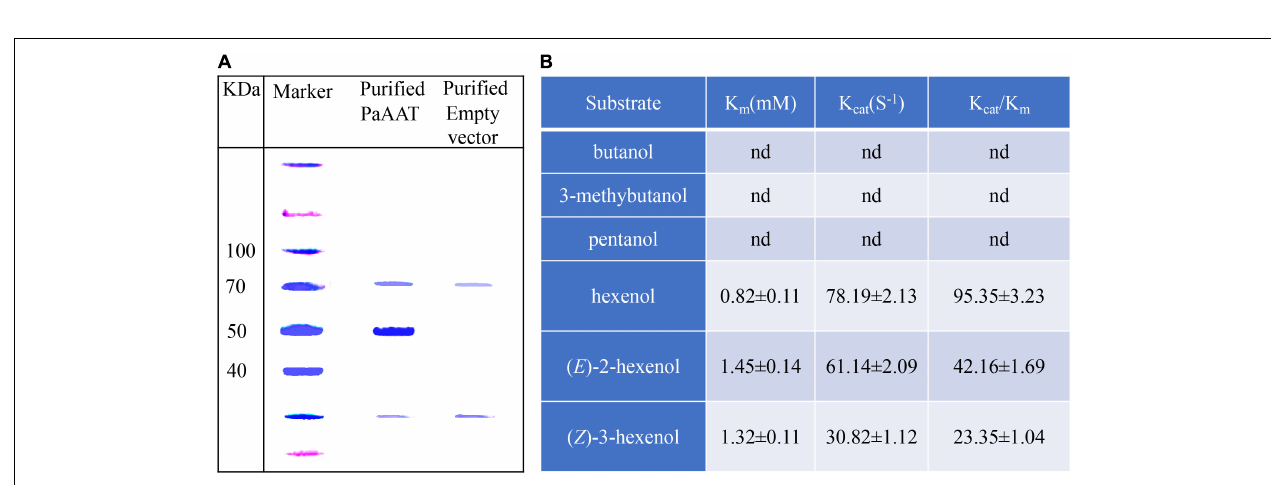
FIGURE 6 | The proteins purified from E. coli and its enzyme activity in vitro . (A) The SDS-PAGE analysis of recombinant PaAAT proteins purified from E. coli ; (B) the kinetics of properties of PaAAT1 recombinant protein. Data are presented as the means ± SE. n.d. represents not detectable.